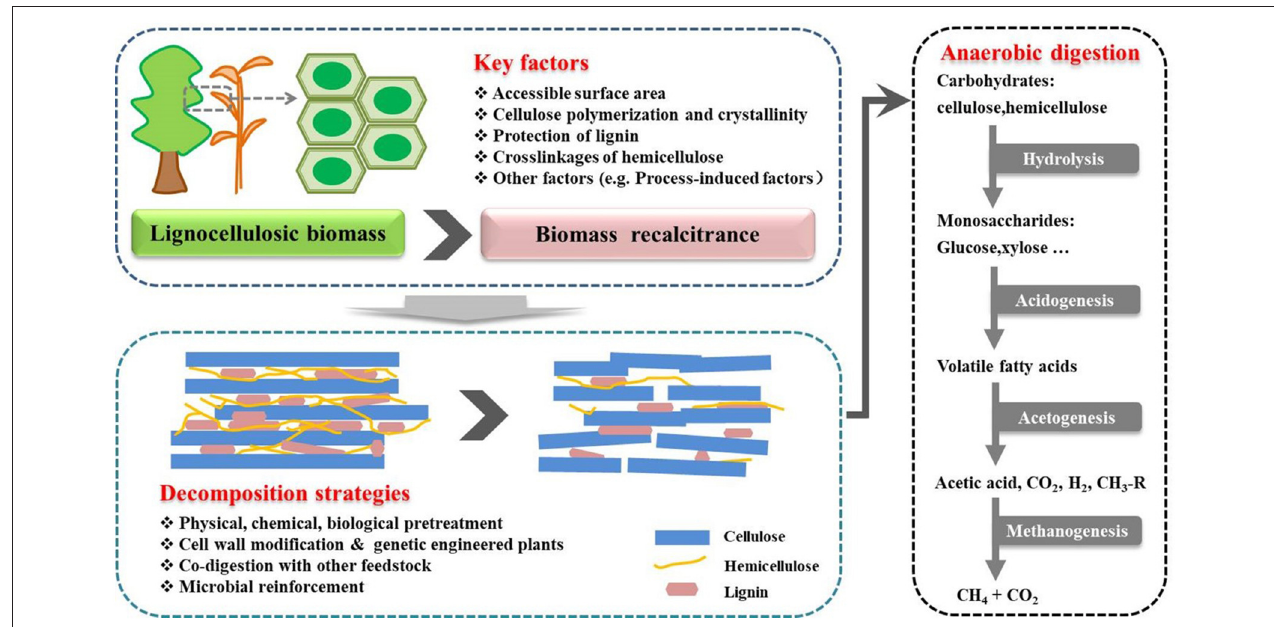
FIGURE 1 | Process stages of the conversion of lignocellulosic biomass to biomethane. Biomethane production is a naturally occurring biological process, which can be divided into four stages. Recalcitrance of lignocellulose restricts the hydrolysis during the first stage. Pretreatment is necessary step for biomethane production. The positive effects of pretreatment strategies can help to facilitate the hydrolysis of lignocellulosic in the first stage ( Florian et al., 2013; Hagos et al.,